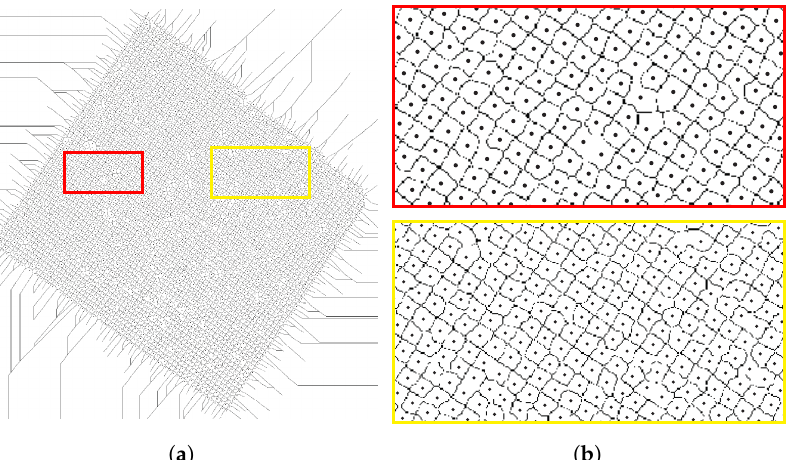
Figure 13. Vine and background related markers set to regional minima. ( a ): whole image, ( b ): mag- nified boxes.